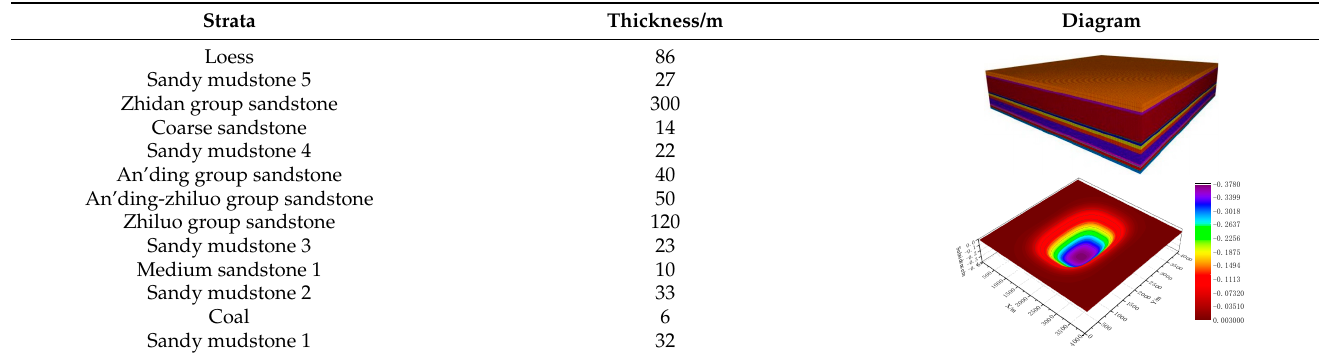
Table 8. Three-dimensional numerical model [49].